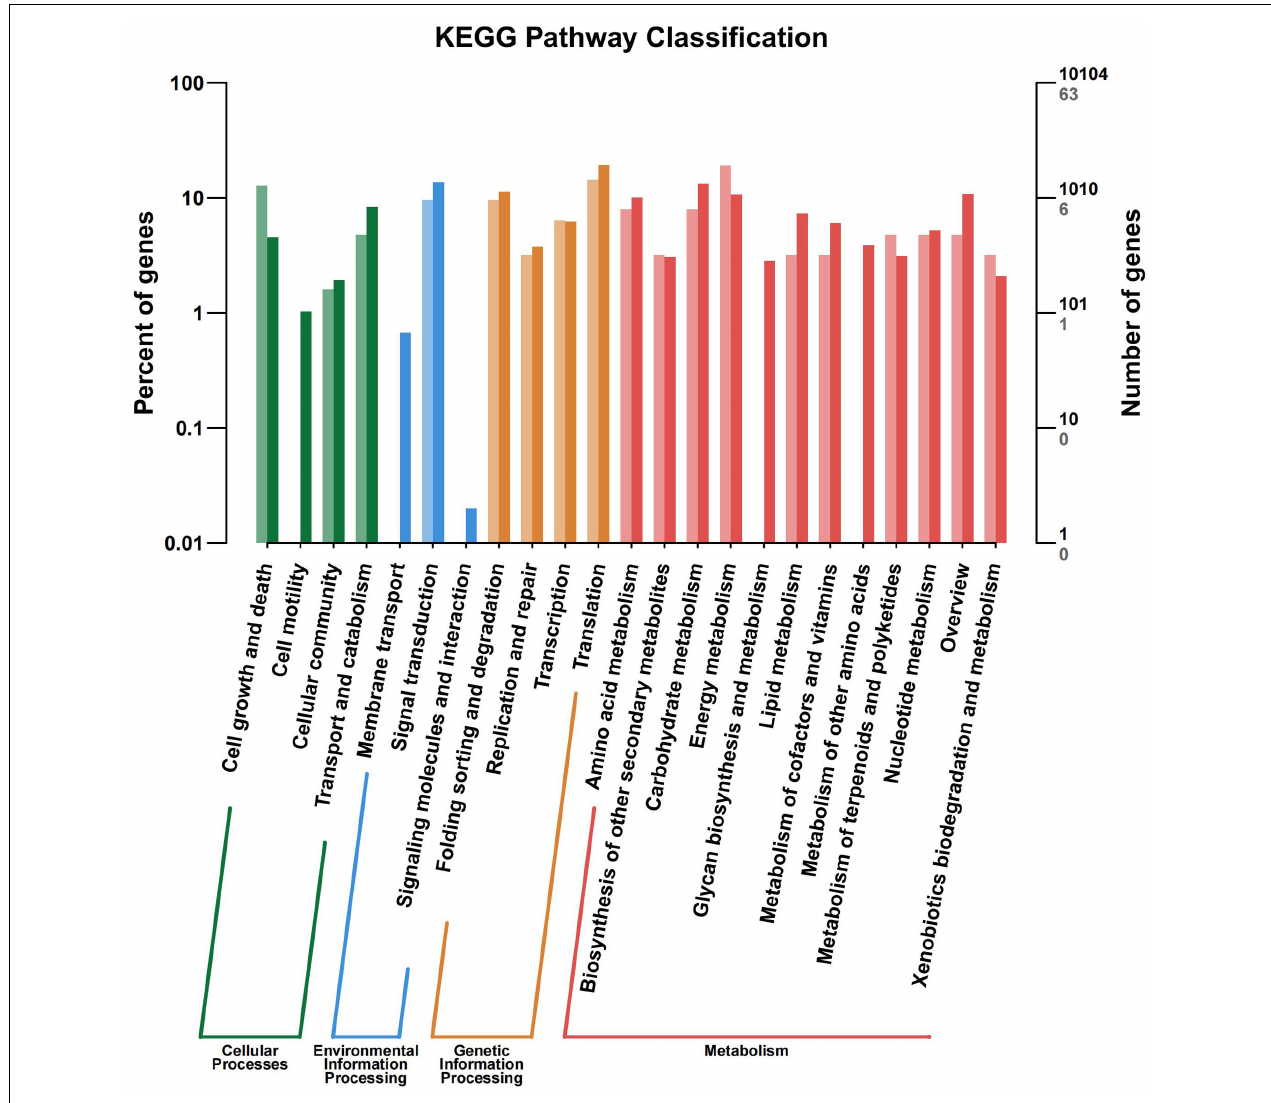
FIGURE 6 | KEGG pathway terms assignment of differentially expressed genes (DEGs) in the leaves of Cyclocarya paliurus between low and high altitudes.